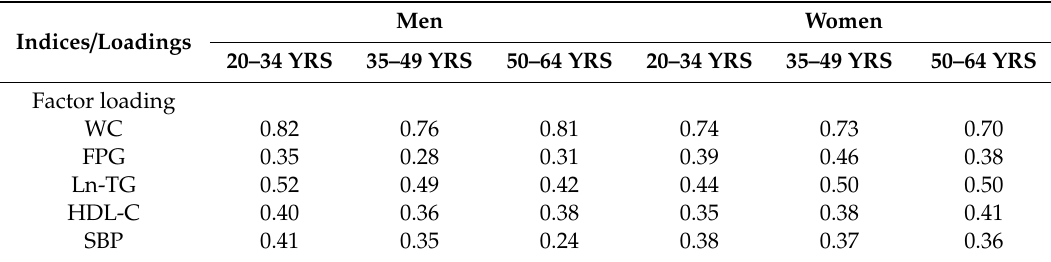
Table 3. Equations used to calculate sex- and age-specific metabolic syndrome severity scores Sex-age Groups